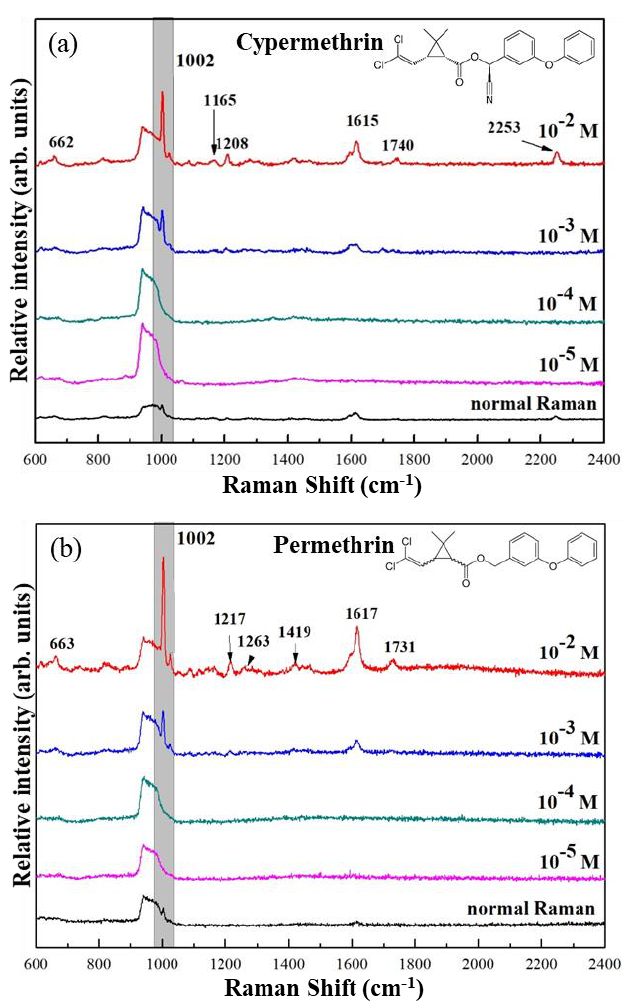
Figure 4. SERS spectra of ( a ) Cypermethrin and ( b ) Permethrin at varying concentrations taken with a 633 nm-wavelength laser.